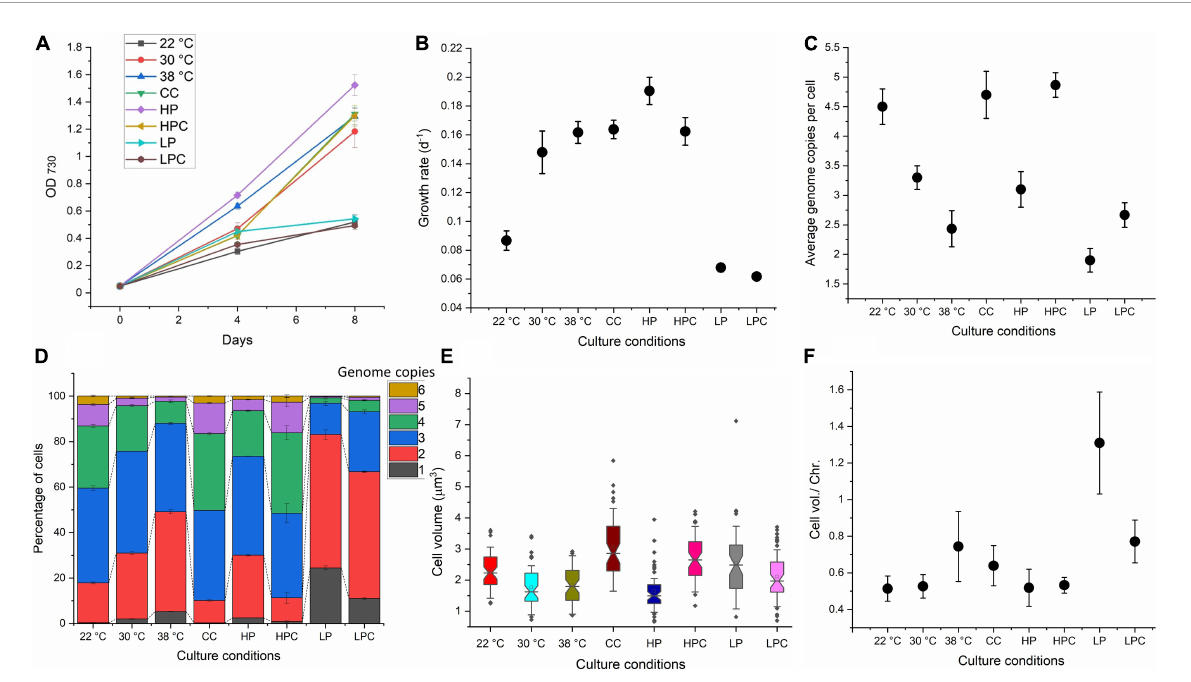
FIGURE2 Ploidy estimation of Synechococcus 7942 under different temperature and nutritional conditions. (A) Growth curve of Synechococcus 7942 at different tested conditions. Samples for the analysis were taken from all conditions on day 4 (OD 730 : 0.4–0.5), which was the mid or late log phase. (B) The specific growth rate of Synechococcus 7942 at different tested conditions. (C) The average genome copies per cell under all tested conditions. (D) Distribution of genome copies among the populations of Synechococcus 7942 under different tested conditions. (E) Cell volume ( µ m 3 ) under all tested conditions was determined using ImageJ. (F) Cell volume per chromosome ( µ m 3 ) was determined by dividing average cell volume with the ploidy level under test conditions. High carbonates culture (CC); high phosphate culture (HP); high phosphate